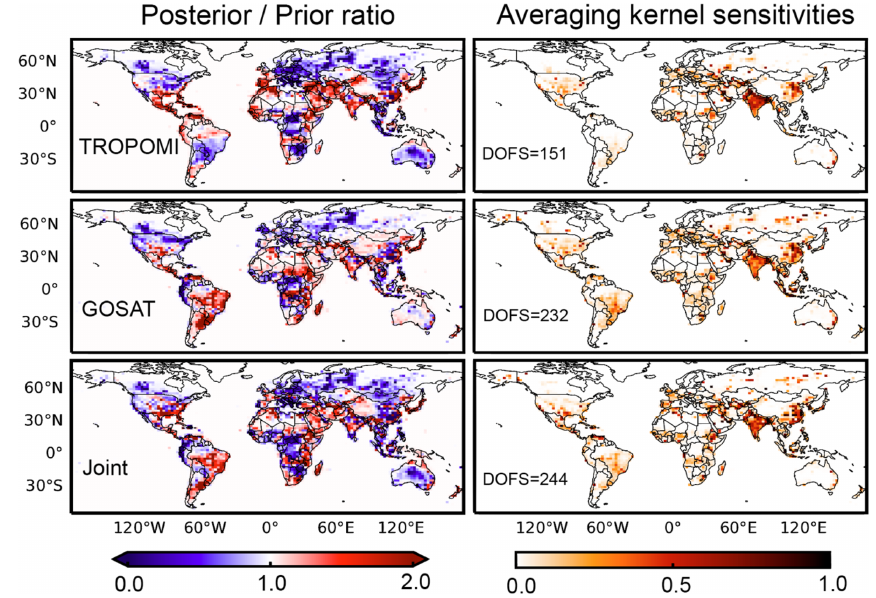
Figure 5. Corrections to prior estimates of 2019 non-wetland methane emissions on the 2 ◦ × 2.5 ◦ grid (posterior / prior ratios) and cor- responding averaging kernel sensitivities. Results are shown for the TROPOMI, GOSAT, and joint TROPOMI + GOSAT inversions. Less than 3% of grid cells have negative posterior / prior ratios, which is allowed by the statistics but is likely unphysical. The averaging kernel sensitivities are the diagonal elements of the averaging kernel matrix for the inversion and measure the ability of the observations to con- strain the emissions (1 = fully; 0 = not at all). The sum of averaging kernel sensitivities (trace of the averaging kernel matrix) defines the degrees of freedom for signal (DOFS) for the inversion, shown in the inset. DOFS including contributions from wetland emissions and OH concentrations are 155 for TROPOMI and 238 for